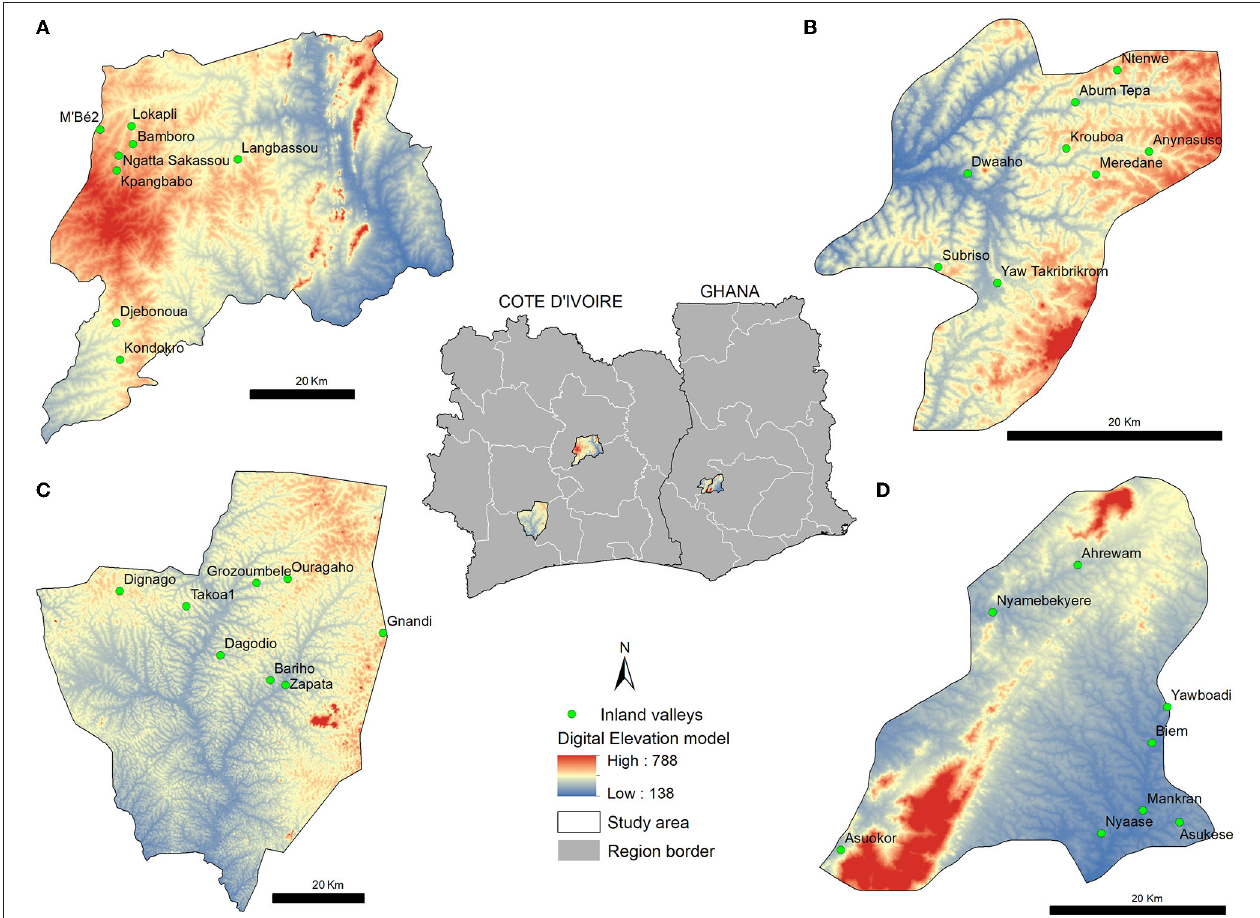
FIGURE 1 | Map of the study area with the four regions and eight inland valleys selected in each region (A) Bouaké [top left], (B) Ahafo Ano North [Top right], (C) Gagnoa [bottom left], and (D) Ahafo Ano South [bottom